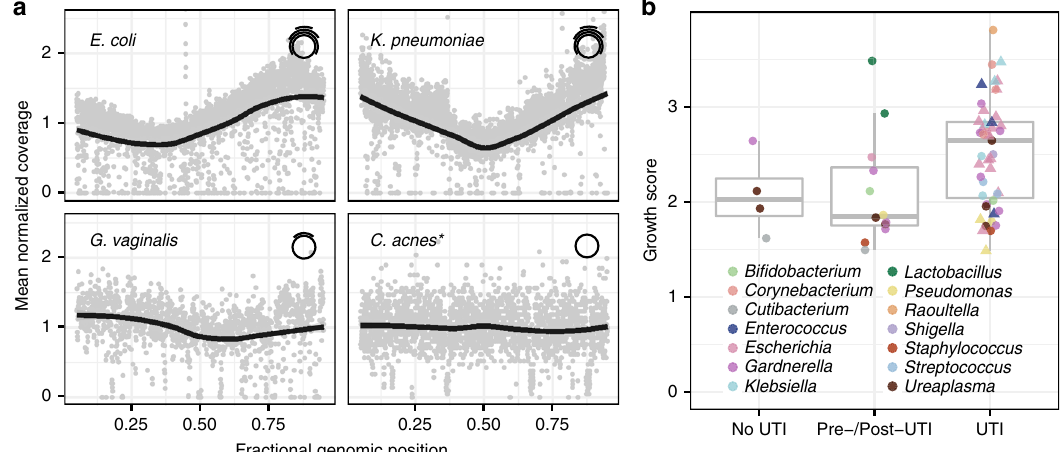
Fig. 3 Estimating bacterial population growth rates from urinary cfDNA. a Normalized bacterial genome coverage for four representative bacterial species. The coverage was binned in 1 kbp tiles and normalized. Each panel represents a single sample (see Supplementary Data 6), with the exception of C. acnes (asterisk (*)) for which the coverage was aggregated across 99 samples (solid line is a LOESS fi lter smoothing curve, span = 0.70). The non-uniform genome coverage for E. coli and K. pneumoniae , with an overrepresentation of sequences at the origin of replication, is a result of bi-directional replication from a single origin of replication. The initial and fi nal 5% of the genome is removed for display. b The skew in genome coverage re fl ects the bacterial growth rate, where a stronger skew signals faster growth 36 . Box plots of growth rates for species in 14 genera grouped by patient groups (at least 2500 alignments, 41 samples, see Methods for de fi nition of pre/post-UTI). Each point indicates a bacterial species in a sample. Triangles indicate culture- con fi rmed bacteria by genus. Boxplot features are described in Methods. See Supplementary Data 6 and